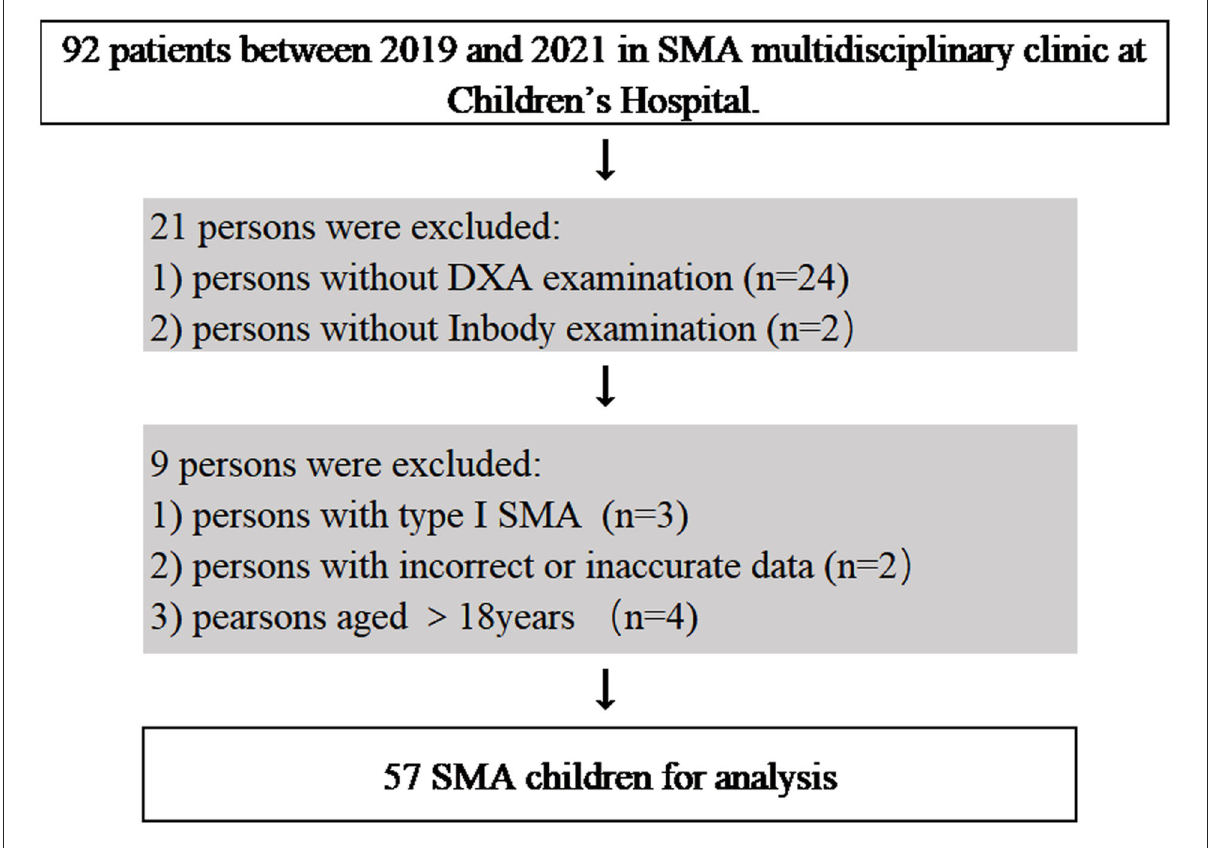
FIGURE1 Flow chart of SMA children in MDT